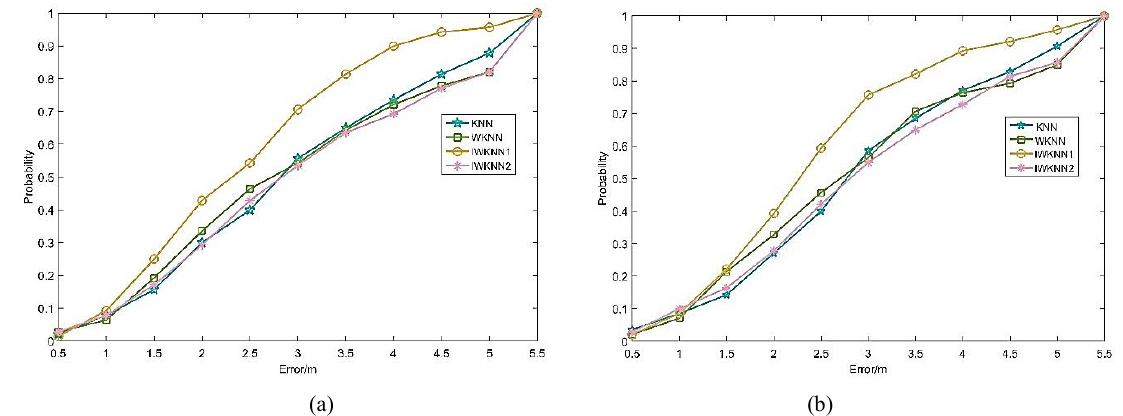
Figure 11 . CDF plots of error for two groups: (a) Positioning results when using the true coordinates of fingerprint points; (b) Positioning results when using the calculated coordinates of fingerprint